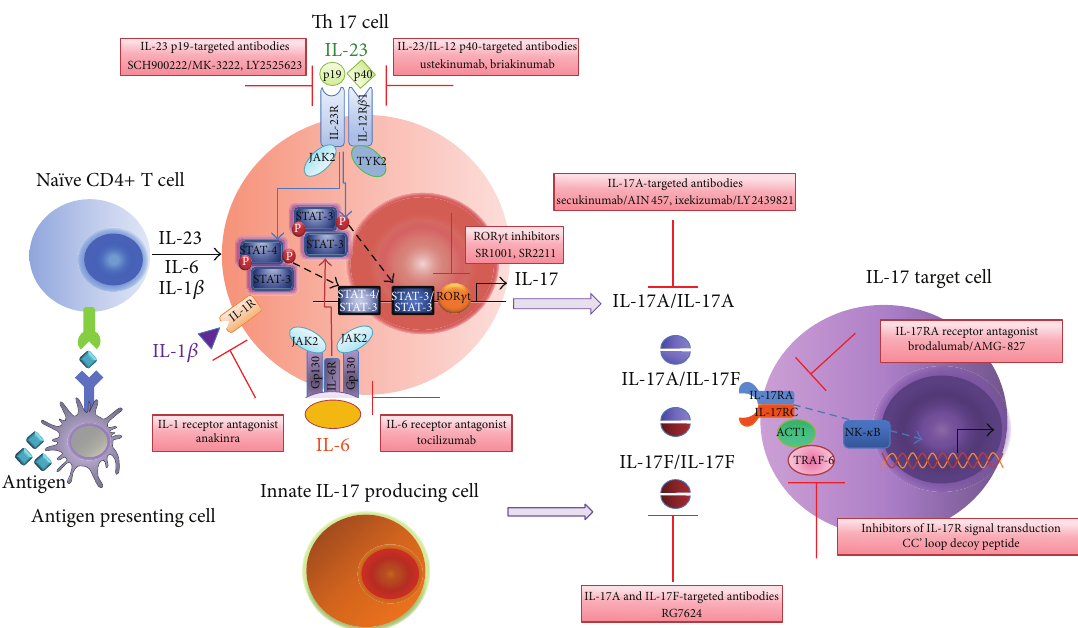
Figure 1: Therapeutic potential of targeting IL-17-mediated pathway. Several novel strategies in which members of the IL-17 family can be targeted are already in use for preclinical and clinical trials, including inhibitors blocking the differentiation of TH17 cells, IL-17 family cytokines or their cognate receptors-targeted antibodies and small molecule inhibitors blocking transduction of IL-17-mediated signaling in target